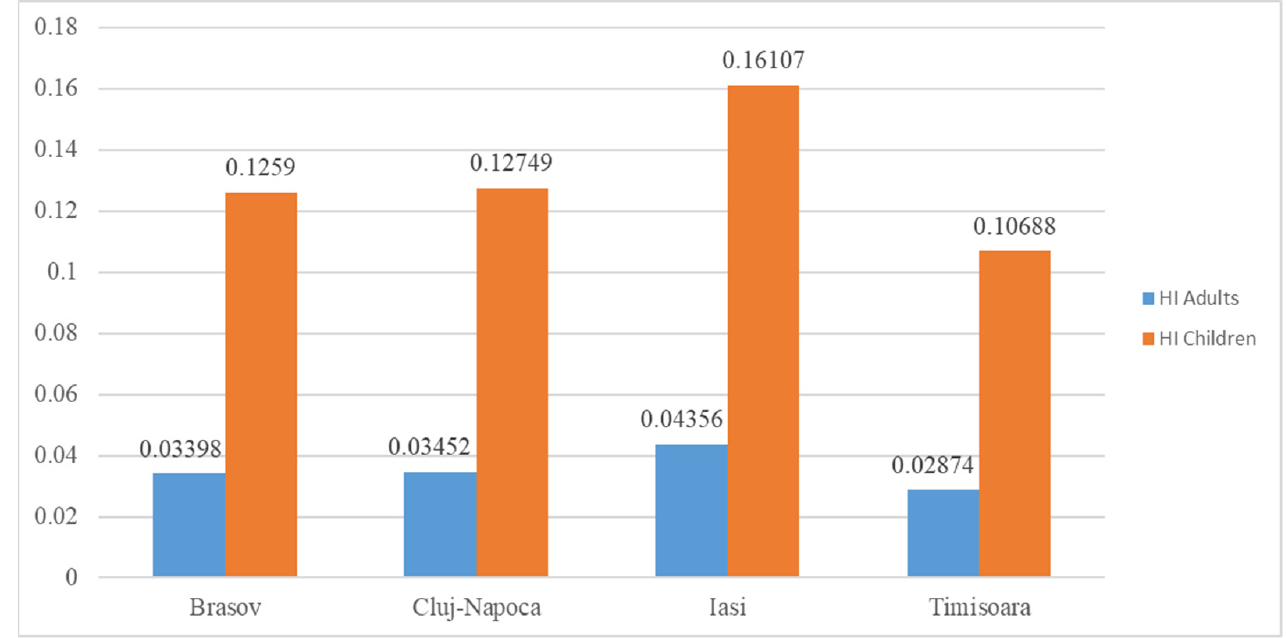
Figure 9. Health risk index for adults and children for the main four cities of Romania.